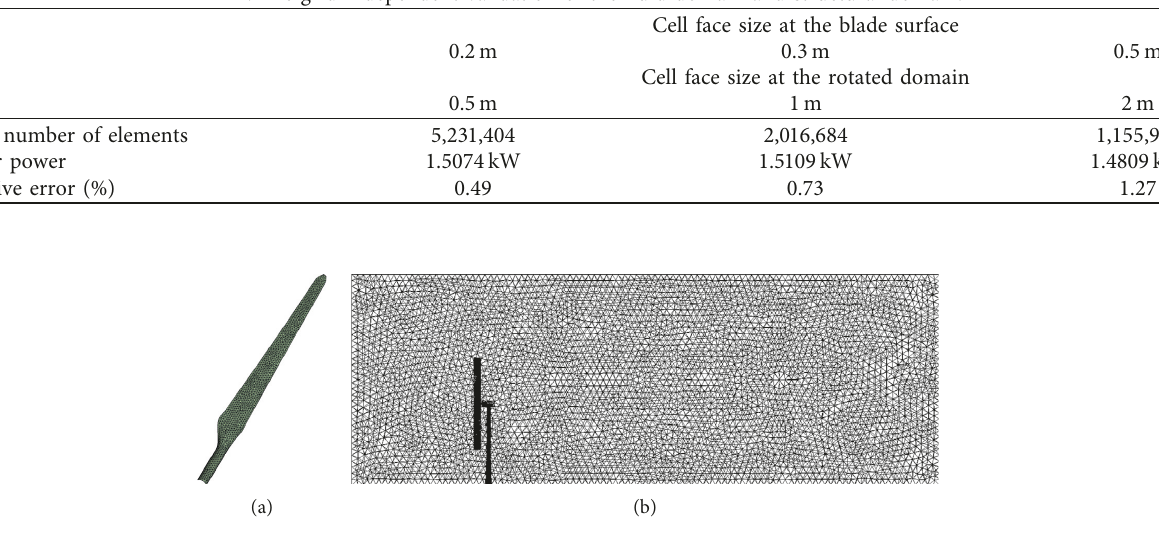
Figure 4: Mesh of the structure and fluid domain: (a) mesh of the blade; (b) mesh of the computational domain.